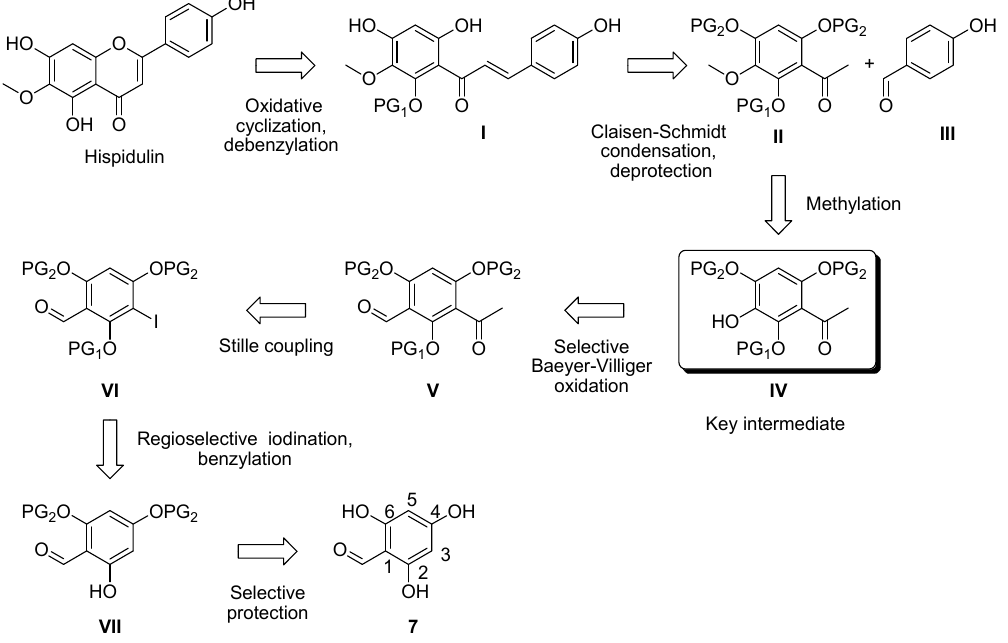
Figure 2. Retrosynthetic analysis of hispidulin.